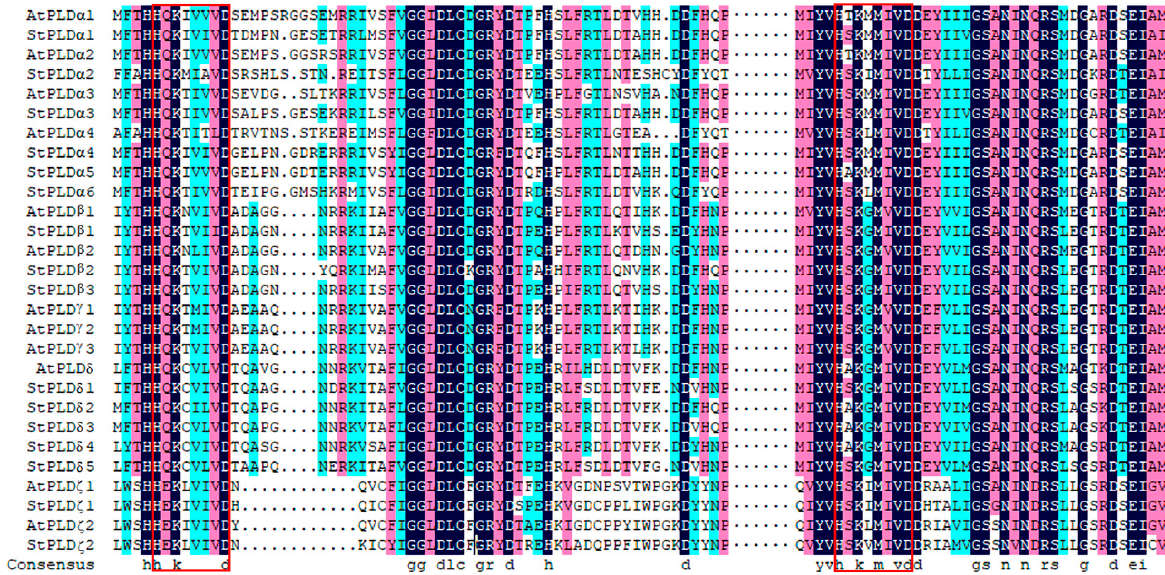
Figure 2. Alignment of potato and Arabidopsis family protein sequences. Amino acids marked in dark blue indicate 100% sequence identity, pink indicates ≥ 75% identity, and light blue indicates ≥ 50% identity. The red boxes indicate the HxKxxxxD domain of the PLD gene family.